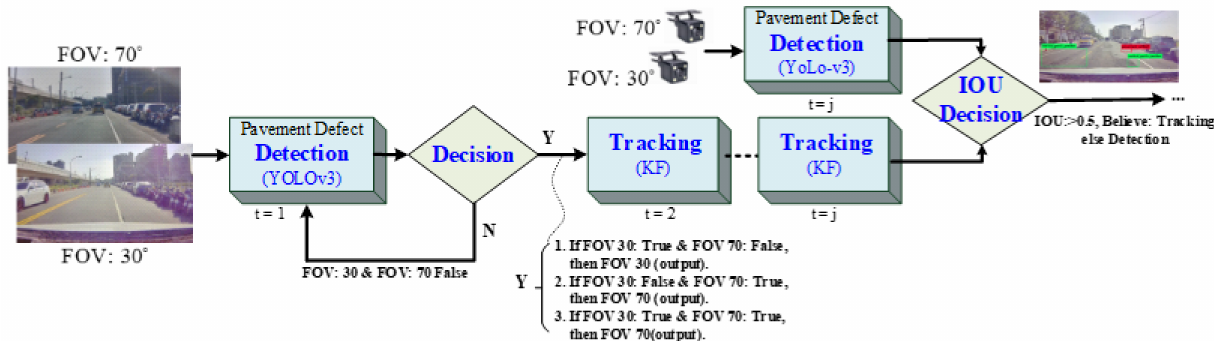
Figure 2. Tracking-via-detection framework.